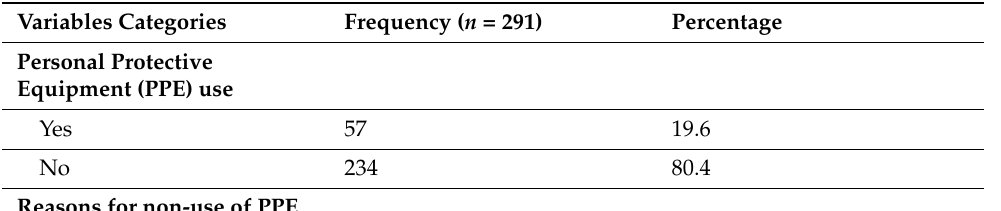
Table 2. Behavioral and psychosocial characteristics of respondents in the integrated textile industry, Addis Ababa Ethiopia,